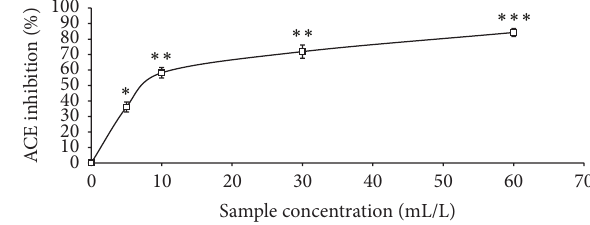
Figure 4: 𝛼 -Amylase inhibitory activity of essential oils from black pepper. Values represent means ± standard deviation of triplicate readings.